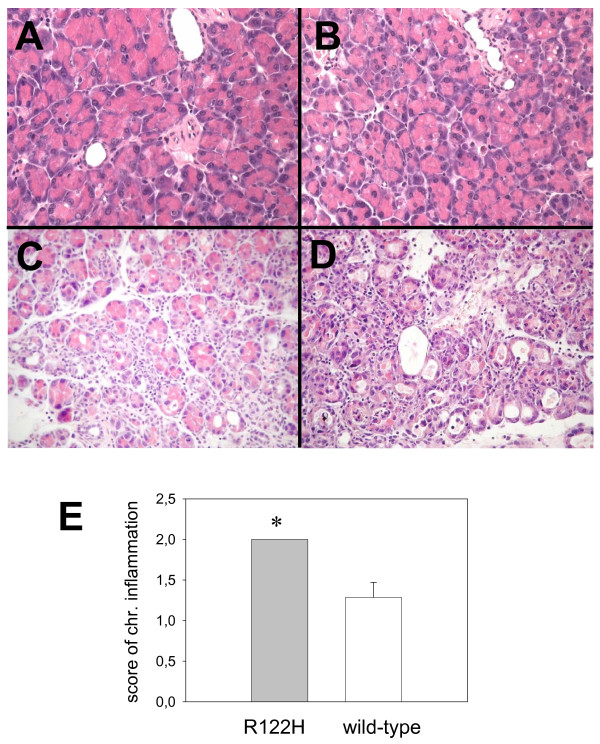
Histological evaluation after repeated induction of pancreatitis in transgenic mice and controls: R122H transgenic animals and controls were sacrificed without treatment (a, b) or after repetitive induction of experimental pancreatitis (c, d) R122H transgenic mice (grey) and controls (white) were left untreated or were treated with repetitive inductions of pancreatitis in a minimum of 7 animals per group. Pancreata of the animals were histologically evaluated for the grade of diffuse infiltration (e). R122H transgenic mice (d) showed significantly higher grade of diffuse inflammatory infiltration than control animals (c). Statistical analysis using the Mann-Whitney-Test with p < 0.05 was considered significant.